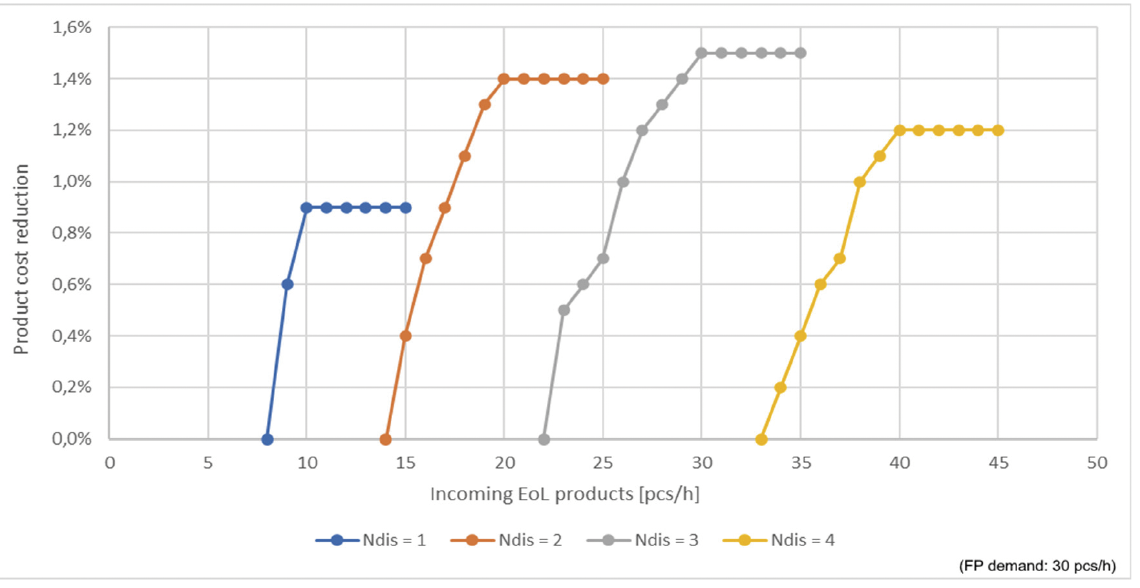
Figure 7. Percentage decrease in the cost of the product as the number of incoming EoL products